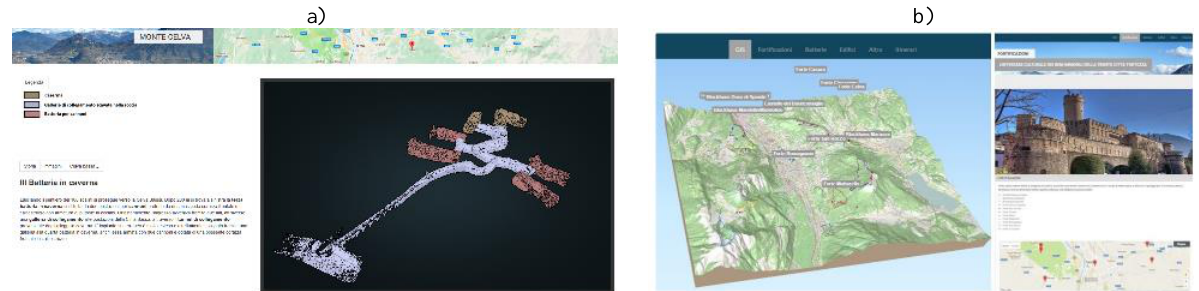
Figure 8. (a) The web page on the Austro-Hungarian fortifications and underground tunnels on Mount Celva (Trento, Italy, http://3dom.fbk.eu/repository/3Dpointclouds/celva/index.html). (b) The WebGIS of the ‘Trento Citta’ Fortezza’ project